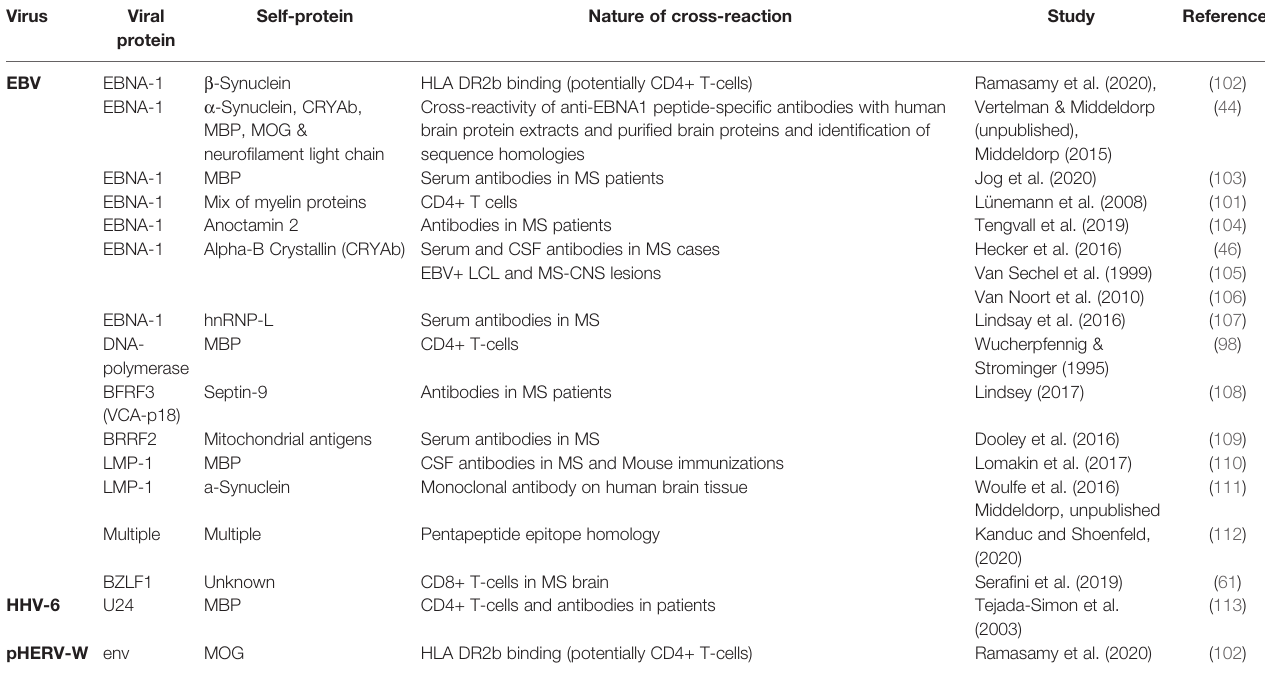
TABLE 1 | Overview of viral proteins involved in antigen mimicry in MS. Virus Viral